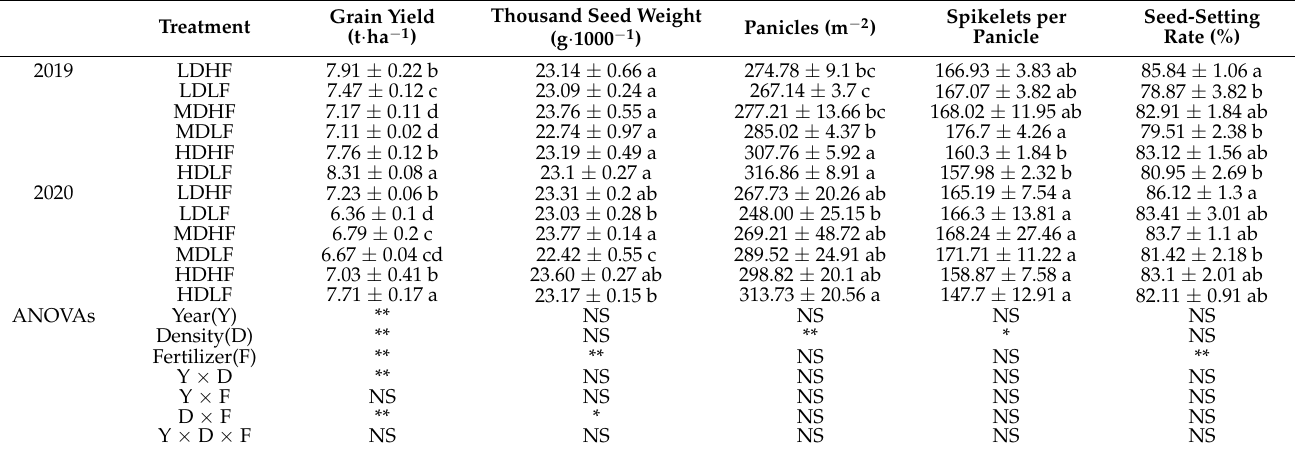
Table 2. Grain yield and yield attributes under single seedling machine transplanting in 2019 and